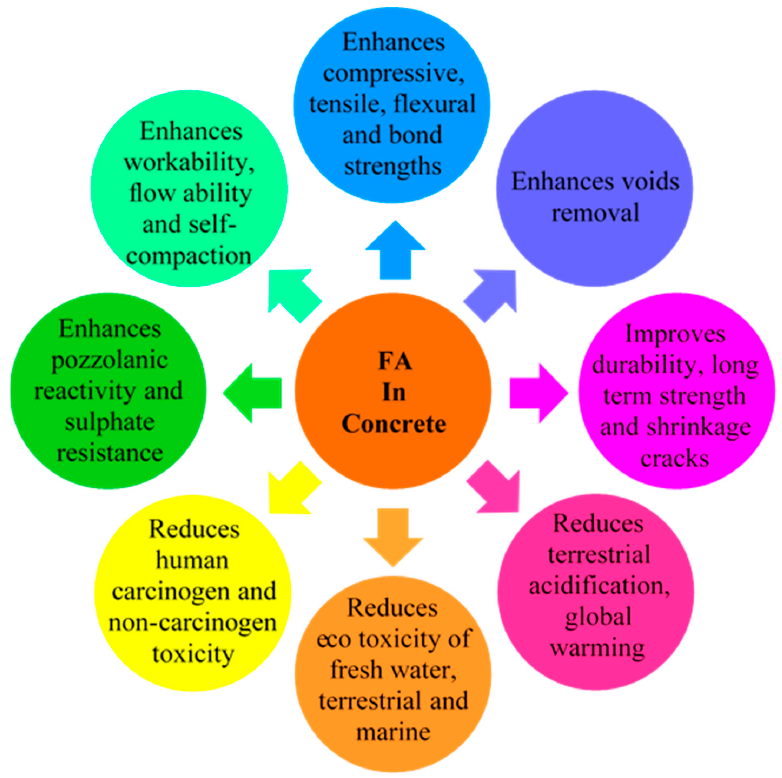
Figure 1. The multiple structural and environmental benefits of FA in sustainable concrete.